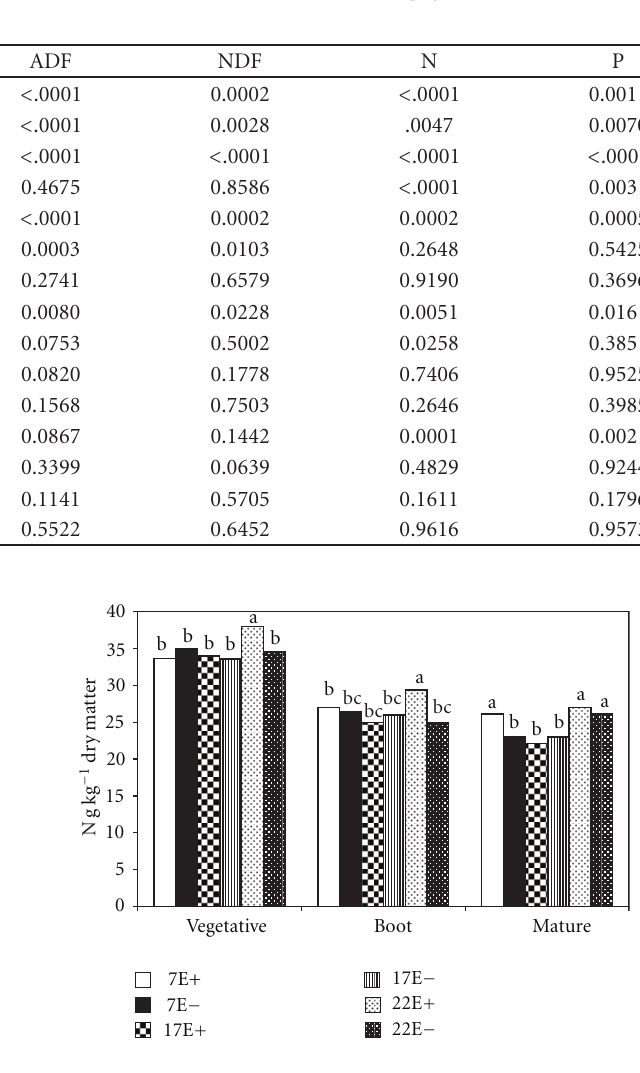
Figure 4: Plant × endophyte × maturity e ff ect on g kg − 1 dry matter NDF concentrations from the greenhouse. Within maturity, bars with di ff ering letters are significantly di ff erent at P = . 05.